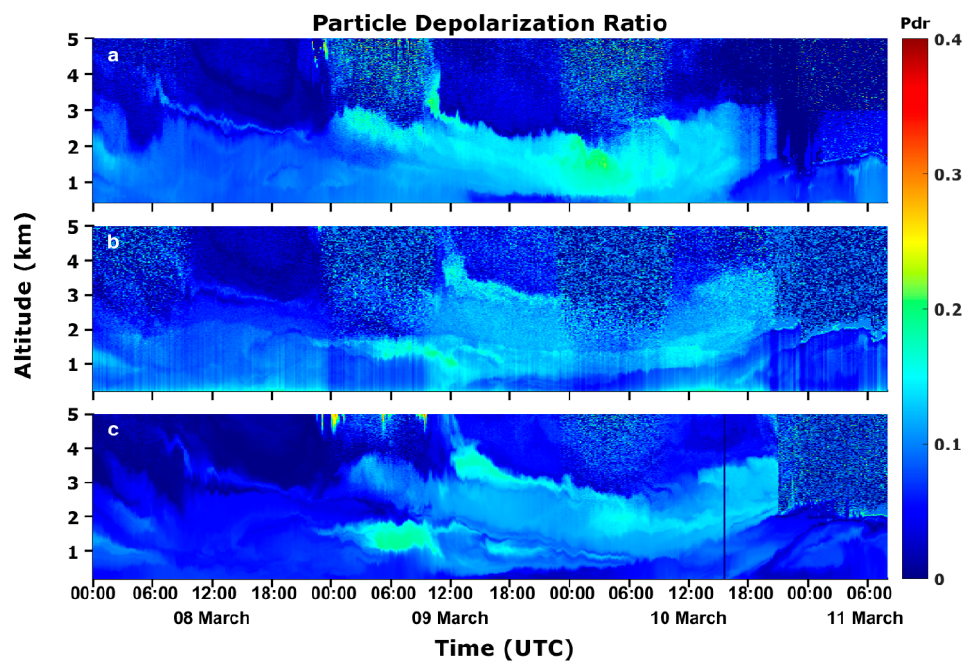
Figure 14. The spatiotemporal distribution of particle depolarization ratio in each region (( a ) Yanqing, ( b ) Haidian, and ( c ) Nanjiao).